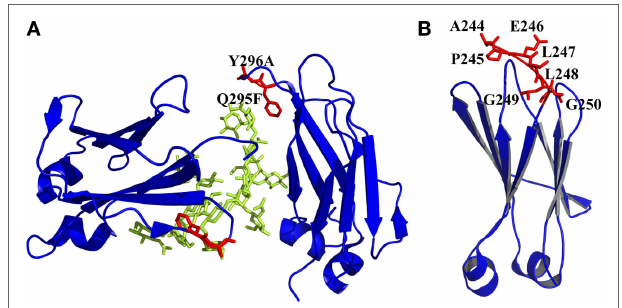
FiGURe 4 | Engineered of loop and other regions in CH2 presented by PyMOL. (A) Introduction of an enhanced aromatic sequon (EAS) (Q295F/ Y296A) in CH2 loop DE [PDB 3AVE (47)]. The mutated residues are colored by red, whereas the oligosaccharides are colored by lemon color. (B) Truncation of N-terminus of CH2. Seven unstructured residues from A244 to G250 are colored by red, which could be removed [PDB 1HZH